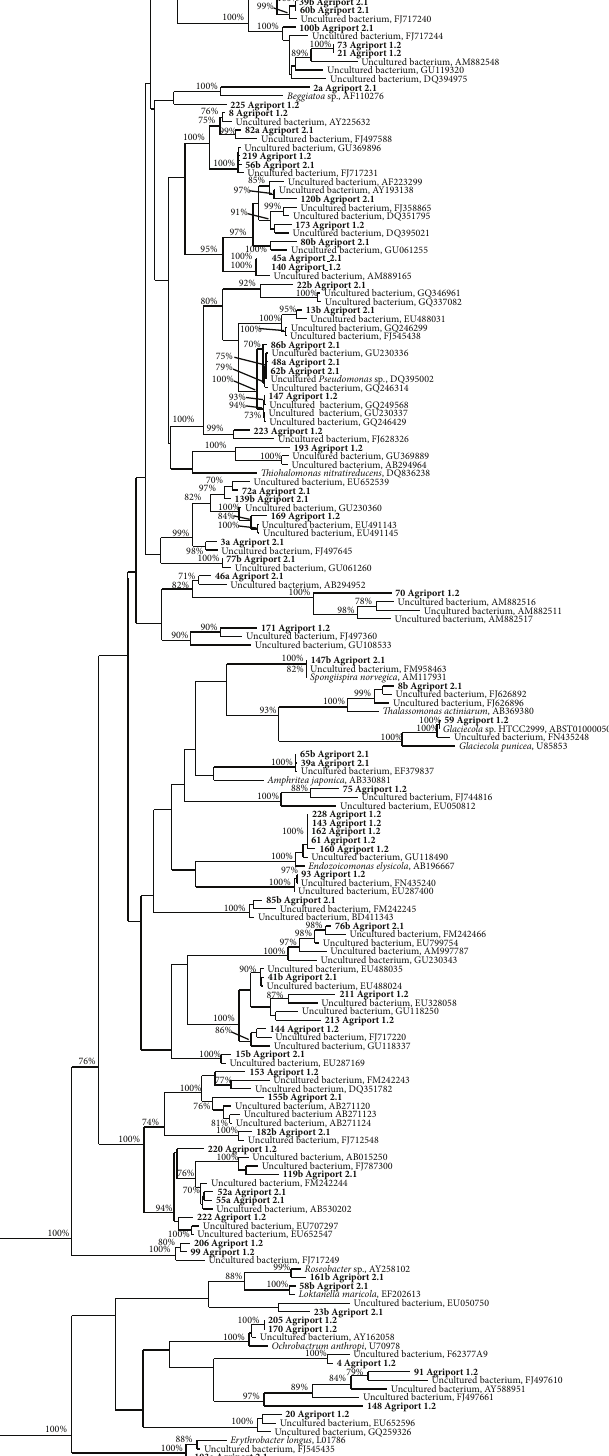
Figure6:MaximumlikelihoodphylogenetictreemadewithPHYMLand100bootstrappseudoreplicates.Thetreerepresentsthephylogenetic position of characterized Alpha- and Gammaproteobacteria clone sequences together with closely related sequences present in the database. The characterized sequences are in